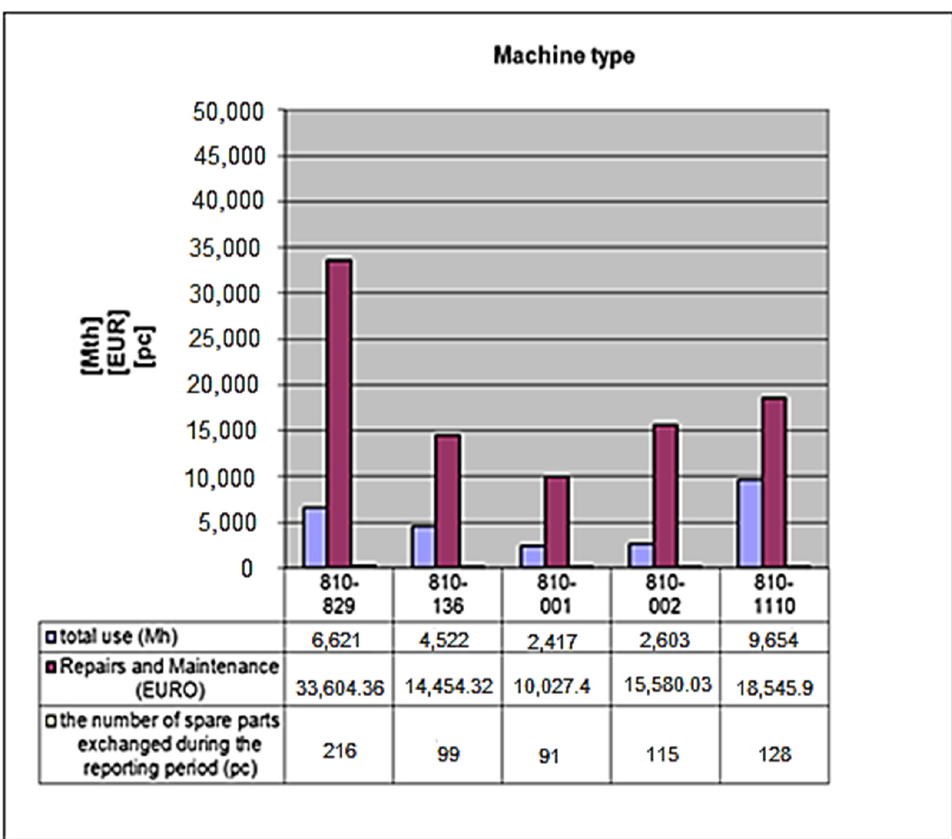
Figure 7 Basic operating data of the observed machines (forwarders) for the monitored